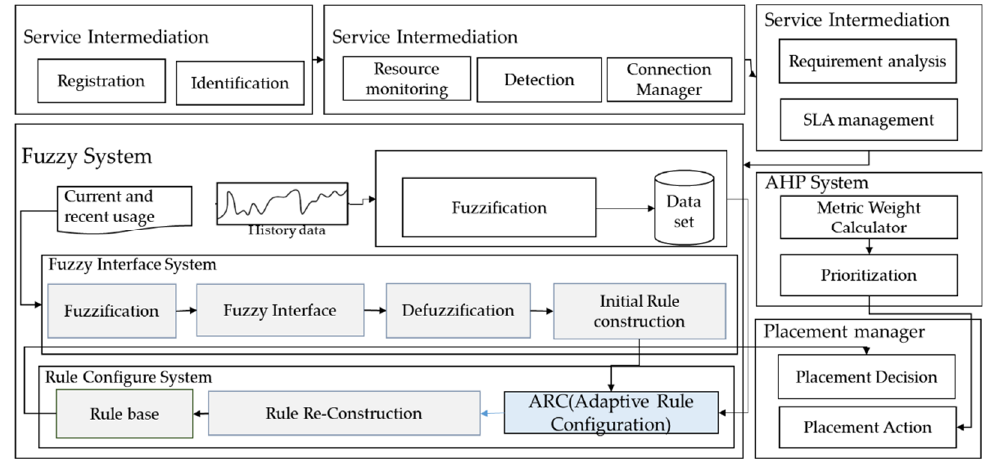
Figure 3. Service placement architecture.